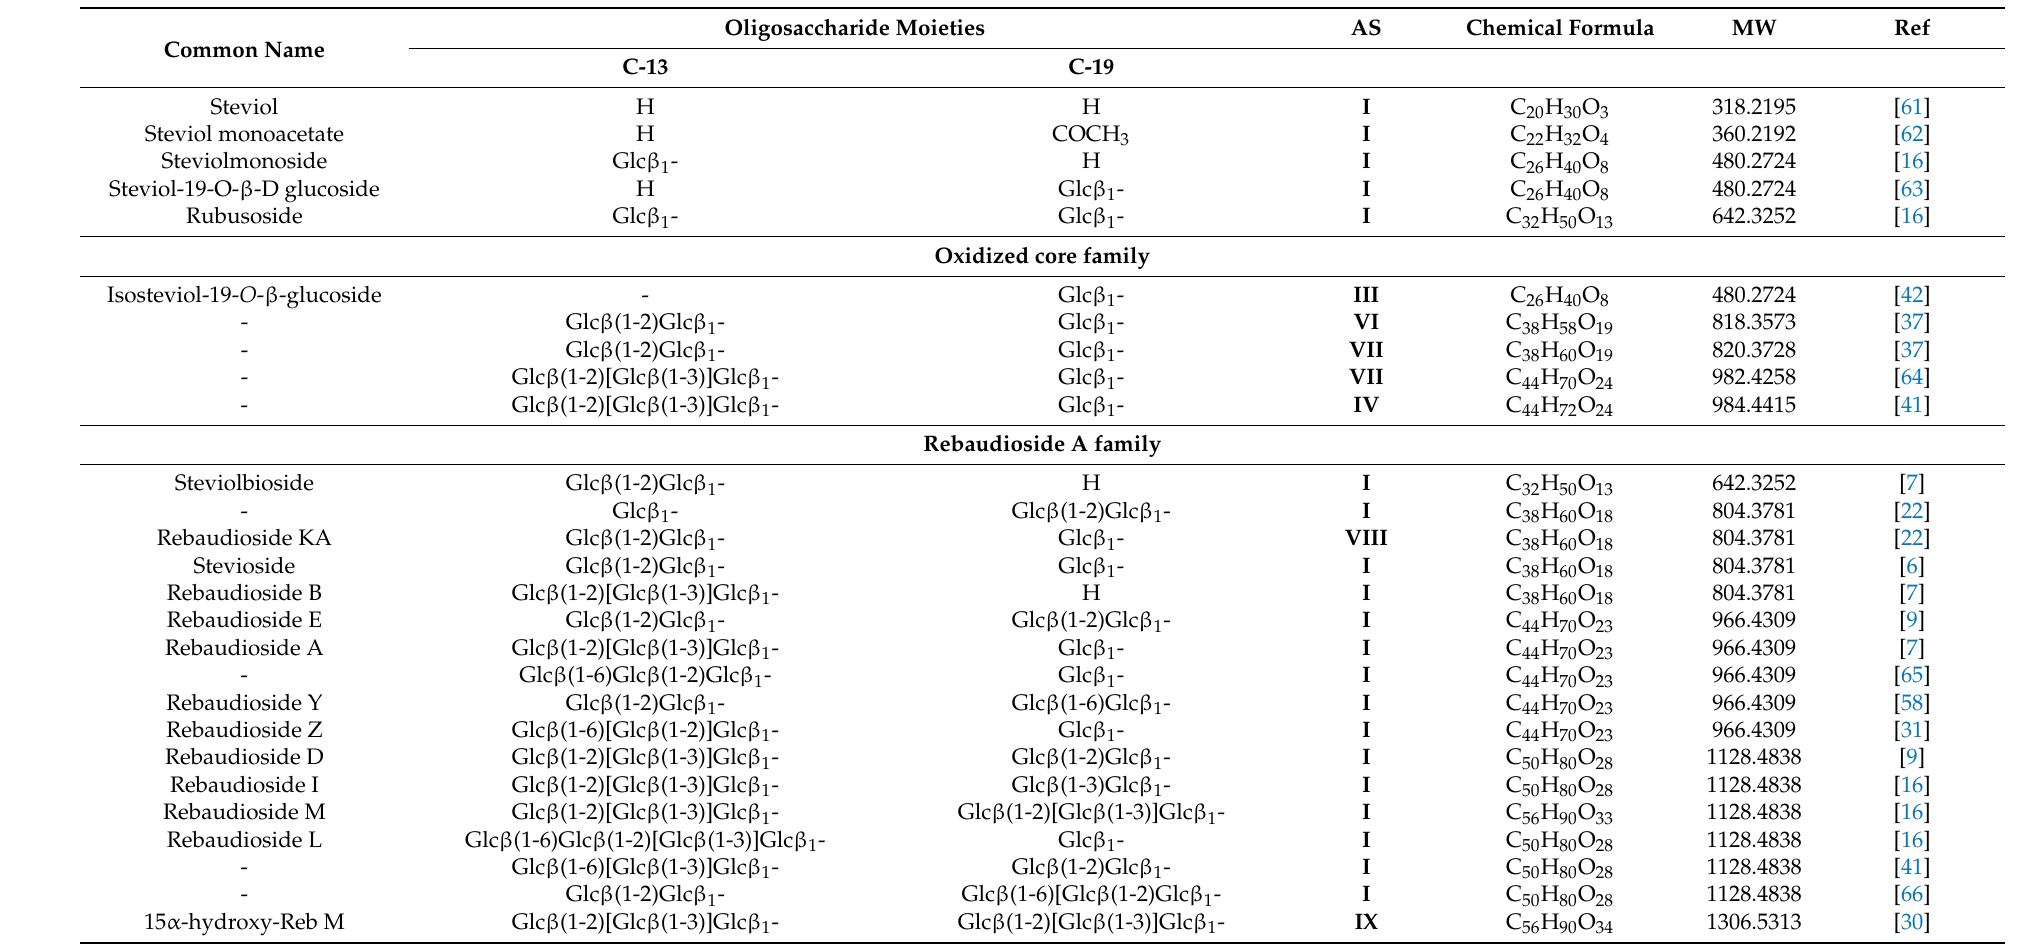
Table 2. Diterpene glycosides purified from Stevia rebaudiana